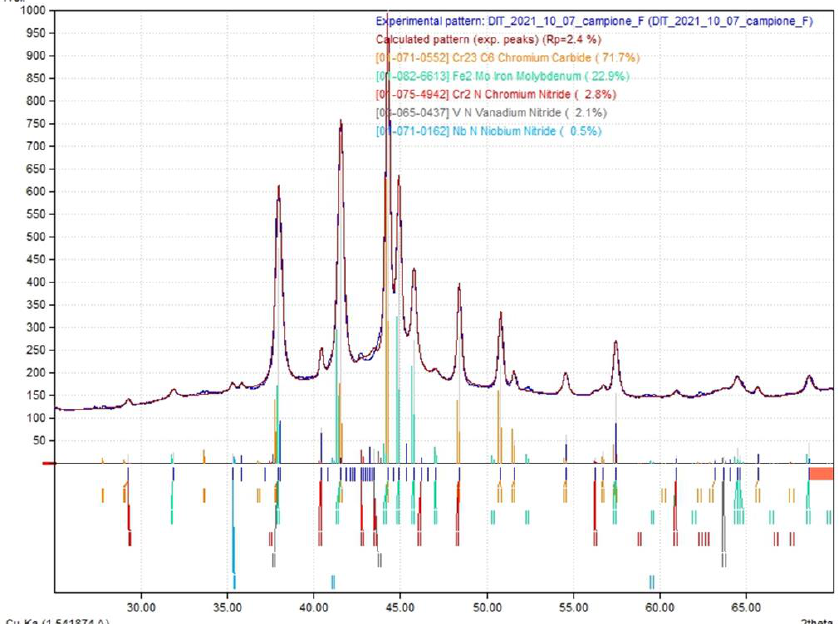
Figure 18. Subproject N°6: GR 92 HAZ CREEP failed crept cross-weld specimen 92-HAZ-6-1 600 °C 152 MPa 2516 h (sample F), XRD analysis.